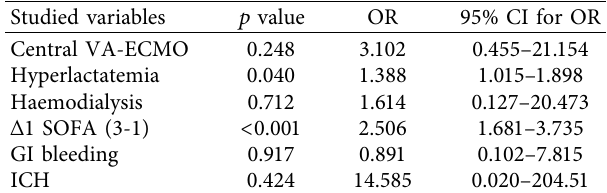
Table 7: Multivariable regression analysis of hospital mortality of patients with cardiogenic shock supported with